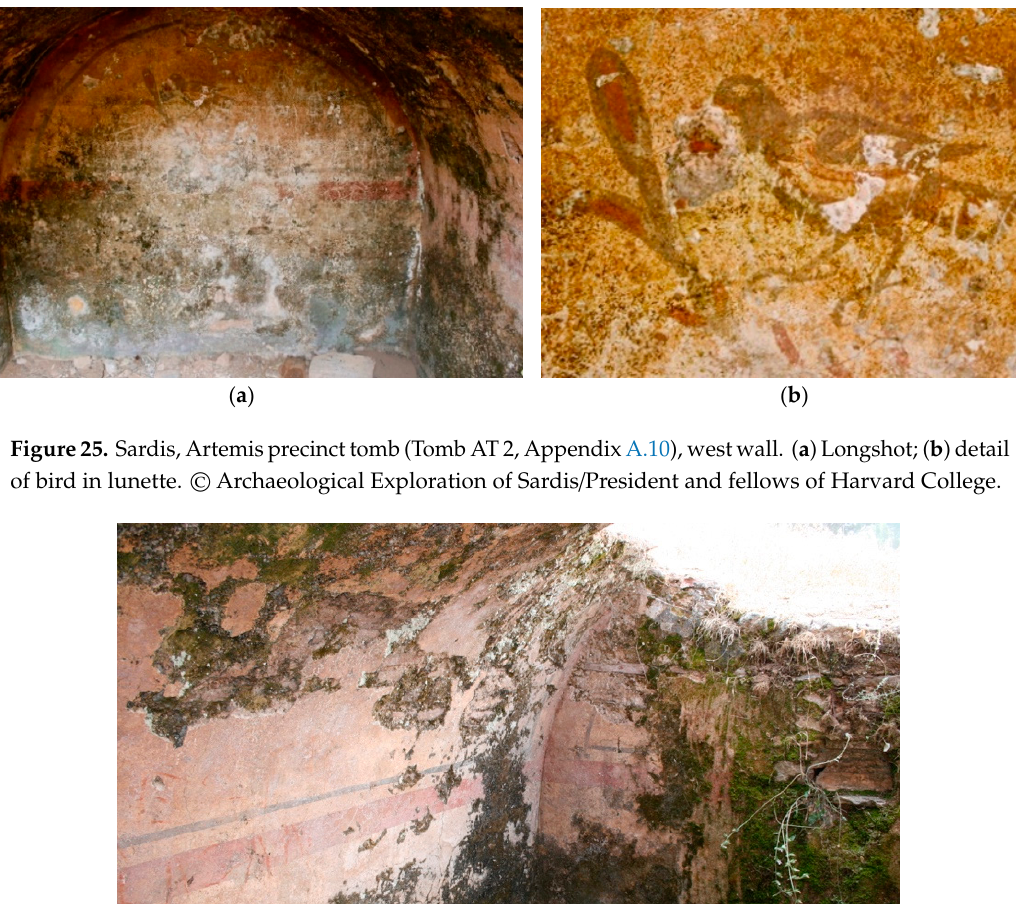
Figure 24. Sardis, Tomb 79.1 (Appendix A.8), southwest corner. © Archaeological Exploration of Sardis/President and fellows of Harvard College.